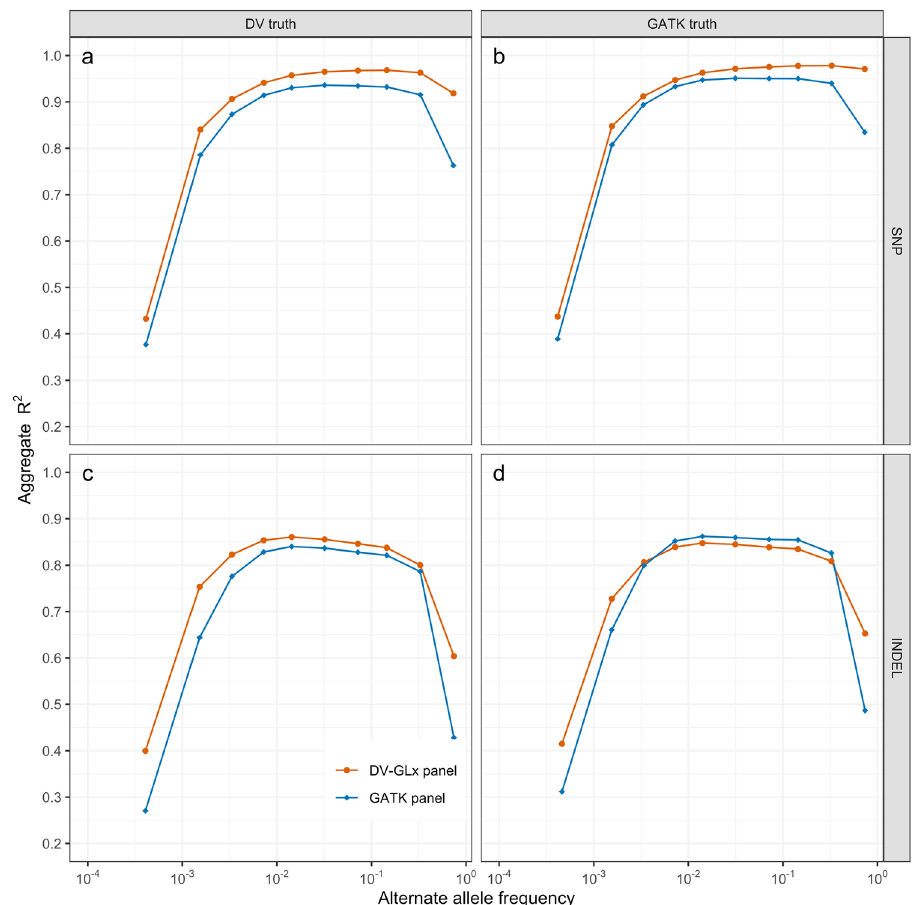
Fig. 3 Imputation accuracy of candidate AFAM reference panels with 1KGP individuals of African ancestry. Aggregate R 2 using DeepVariant-GLnexus optimized reference panel (DV panel) and GATK Best Practices (GATK panel) when imputing Illumina HumanOmni 2.5 genotype array calls and evaluating on deeply sequenced (30×) “ ground truth. ” Variants present in the “ ground truth ” but missing from the reference panel are imputed as homozygous reference calls, which penalizes panels that have missing variation. a SNP R 2 using ground truth generated with DeepVariant + GLnexus (DV truth), b SNP R 2 using ground truth generated with GATK Best Practices (GATK truth), c Indel R 2 using ground truth generated with DeepVariant + GLnexus, and d Indel R 2 using ground truth generated with GATK Best Practices. See also Supplementary Fig.